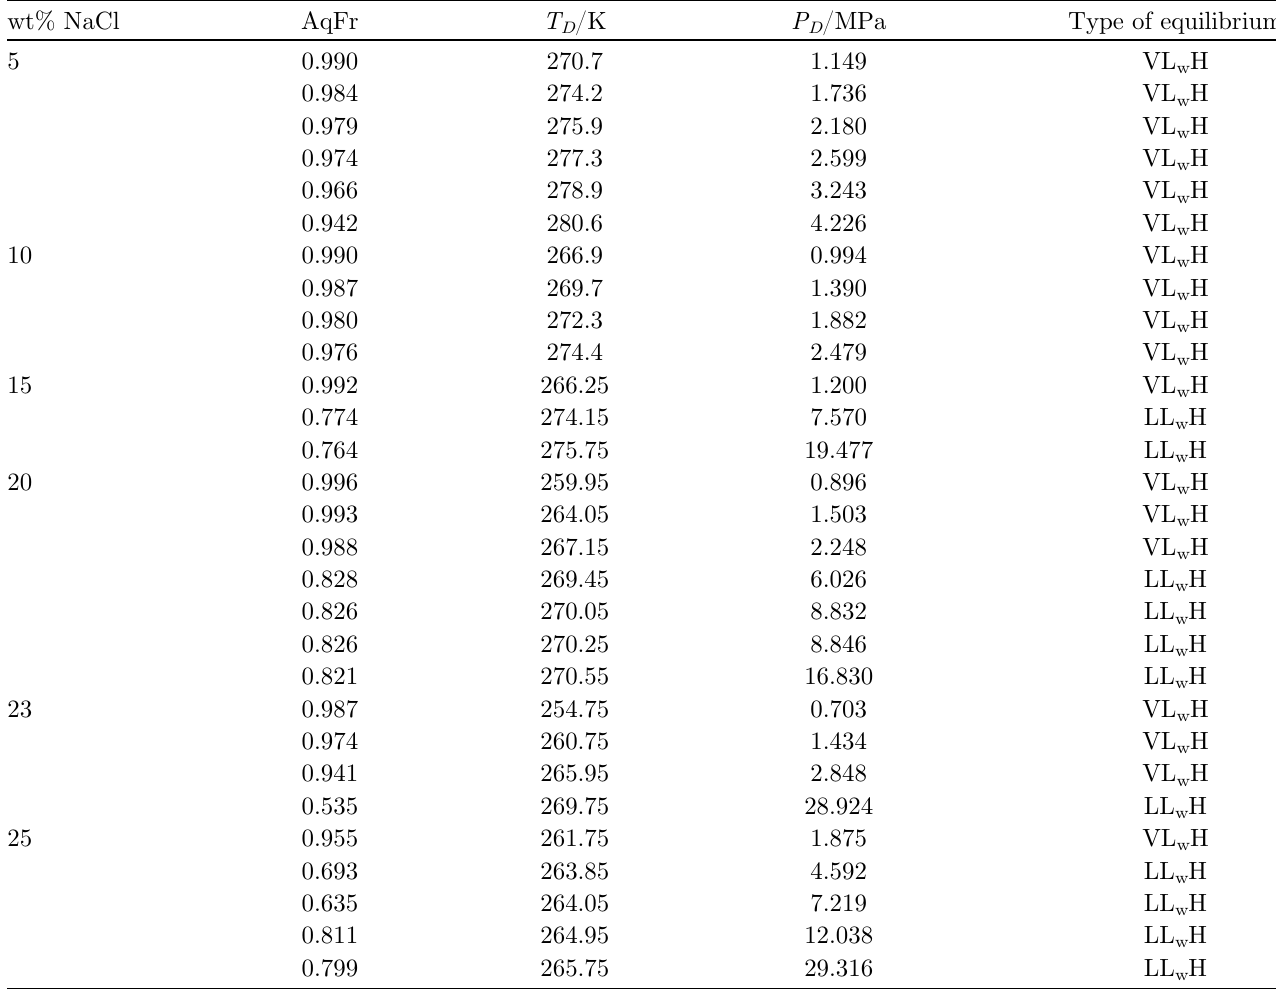
Table 4. Experimental CO hydrate dissociation conditions in the presence of sodium chloride solutions (AqFr: 2 Aqueous Fraction).